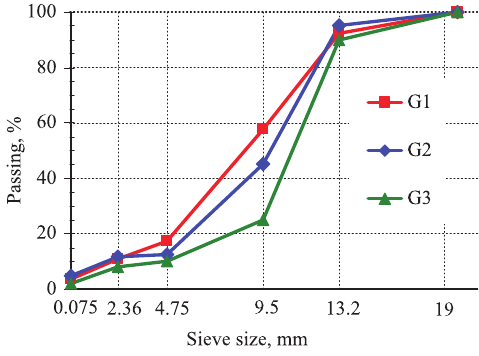
Fig. 1. Gradations investigated for PFC